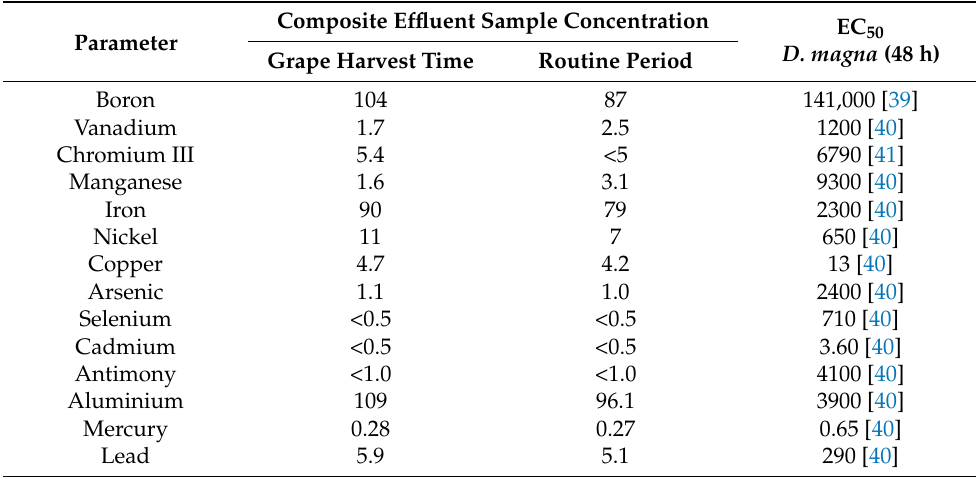
Table 9. Metals and semimetals effluent concentrations measured during both monitoring campaigns (average values, in µ